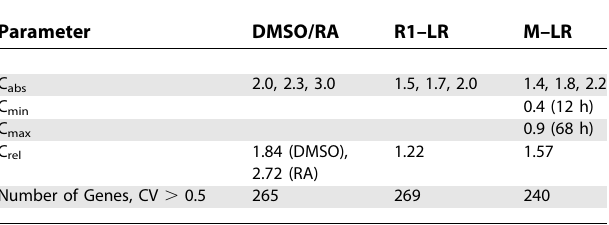
Table 2. Thresholds Used in the Definition of the ESC Signature Change, in Terms of Gene Expression